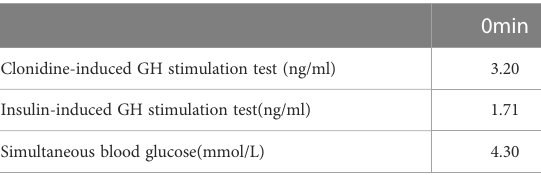
TABLE 1 the results of GH stimulation